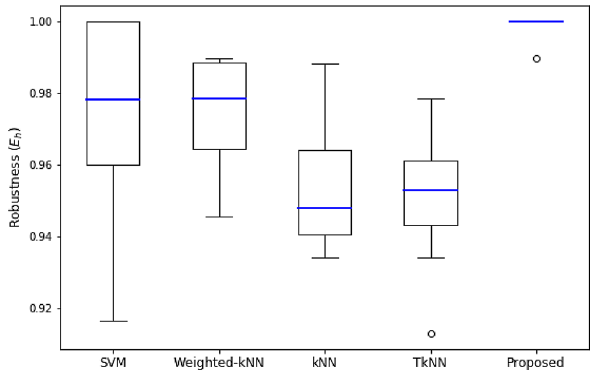
Fig. 1 Robustness of different classifiers using micro-averaged F -measure